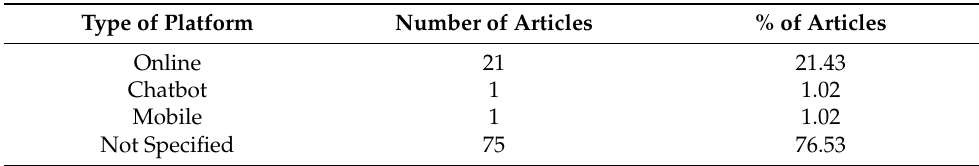
Table 9. Percentage number of articles according to type of